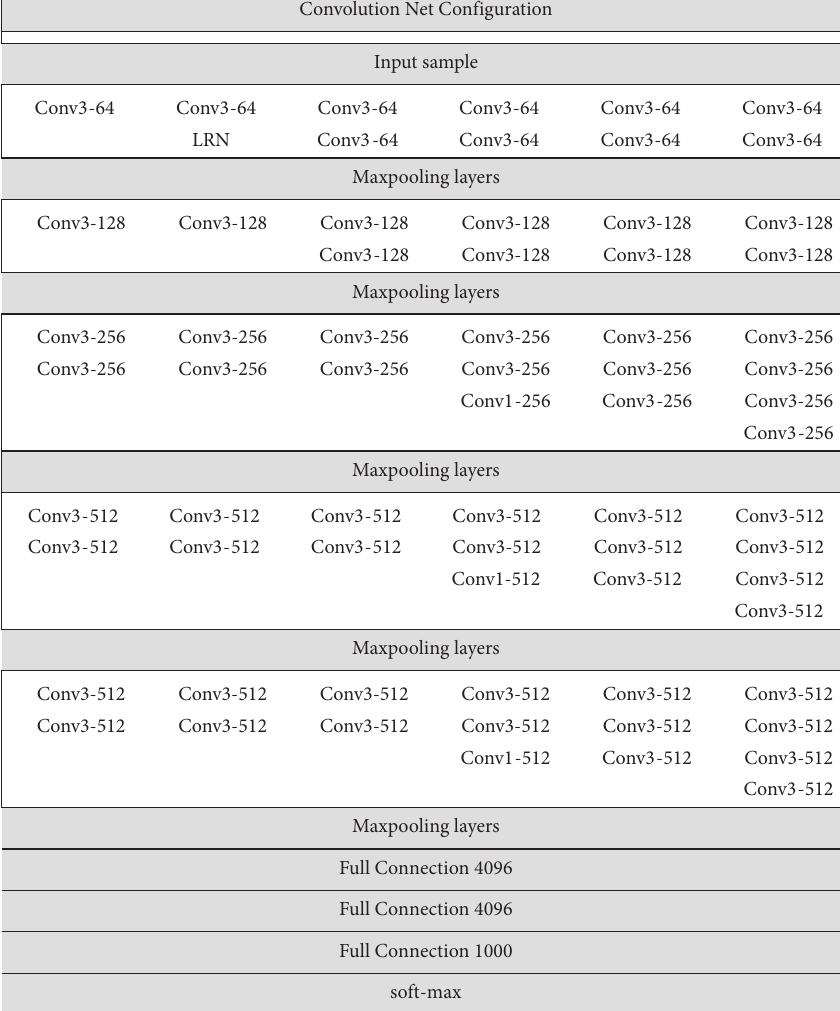
Figure 2: The structure of